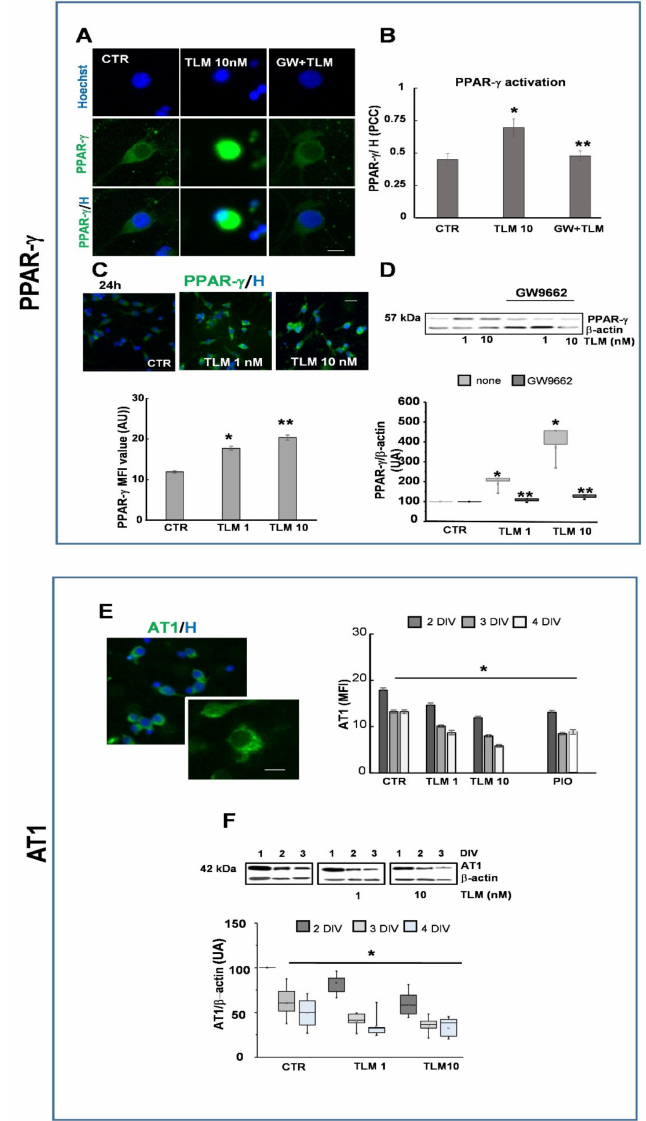
Figure 2. TLM increases the expression of PPAR- γ and modulates the AT1 receptor by a PPAR- γ mediated mechanism. OPs were treated for 60 min with 10 nM TLM in the presence or absence of the PPAR- γ antagonist GW9662 (GW) to study PPAR- γ activation. ( A ) Representative photomi- crographs show PPAR- γ in green and nuclei in blue. The translocation of the receptor is shown as merging of PPAR- γ and Hoechst (H). Scale bar = 10 µ m. Panel ( B ) shows the colocalization of the two signals (PPAR- γ /Hoechst nuclear labelling) expressed as the Pearson correlation coefficient (PCC). Data are shown as Means ± SEM n = 3; 300–400 cells (* p < 0.001 vs. CTR, ** p < 0.05 vs. TLM, unpaired two-tailed Student t -test). The PPAR- γ expression was evaluated by IF and WB analysis after 24 h of treatment with 1–10 nM TLM ( C , D ). Data for IF are shown as Means ± SEM; n = 3; 200–250 cells. Representative bands of PPAR- γ and β -actin are shown above, and densitometric analysis of 3 experiments is shown below ( D ) (* p < 0.001 vs. CTR, ** p < 0.05 vs. TLM, unpaired two- tailed Student t -test). OPs at 1DIV were treated with (1–10 nM) TLM and (1 µ M) pioglitazone (PIO) for 24, 48, 72 h. The AT1 expression was evaluated at 2, 3 and 4DIV by IF and WB. ( E ) A representative photomicrograph and a higher magnification of a single cell is shown. AT1 expression is shown in green and nuclei in blue. Scale bar = 10 µ m. The MFI from 200–250 cells/condition/experiment are shown (* p < 0.001 vs. untreated and treated at each DIV, unpaired two-tailed Student t -test, p = 0.0001 one-way ANOVA). ( F ) Representative bands of AT1 and β -actin are shown above, and densitometric analysis of 3 experiments is shown below (* p < 0.001 vs. untreated and treated at each DIV, unpaired two-tailed Student t -test, p = 0.00018 one-way